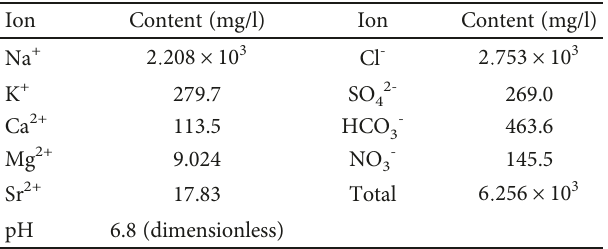
Table 1: Composition of BS8 formation